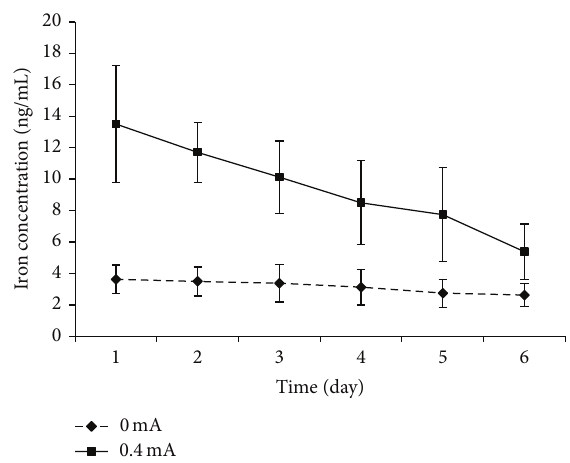
Figure 3: Iron concentrations of collected liquid at different time points following